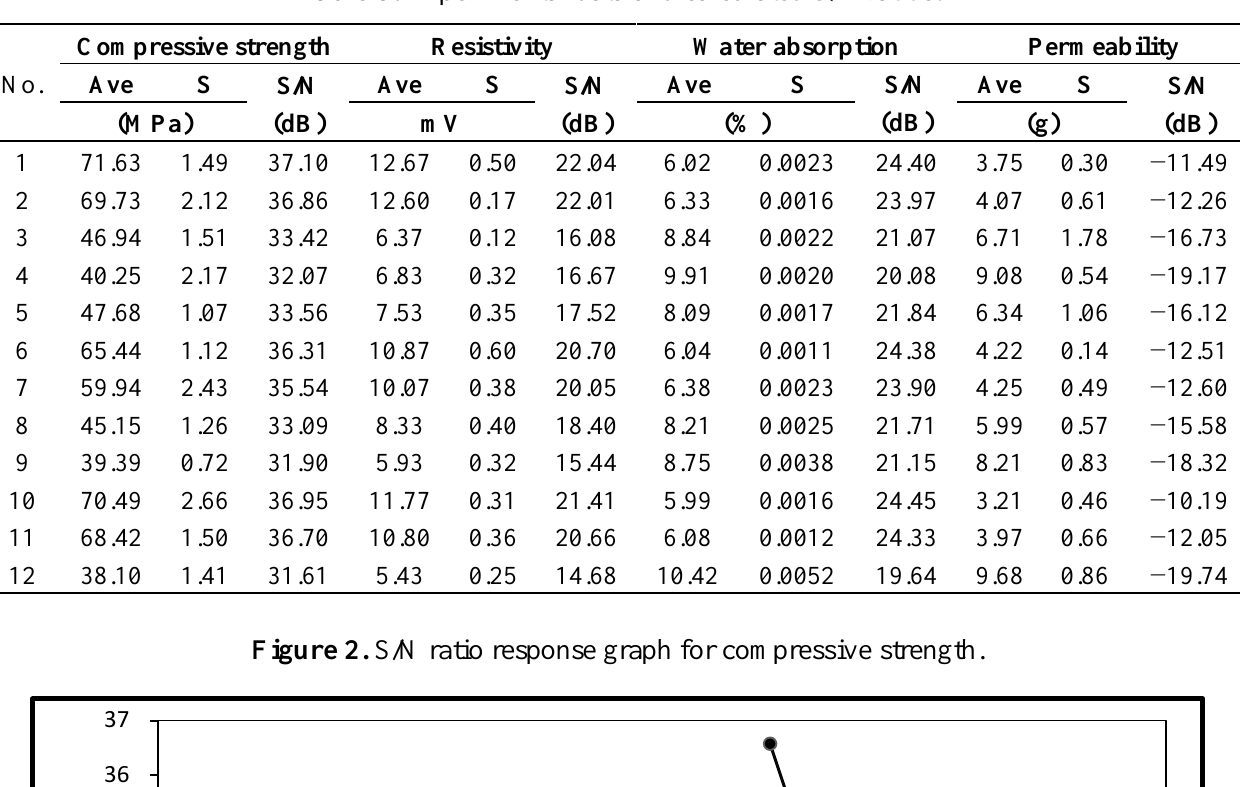
Table 5. Experimental data and calculated S/N ratios.